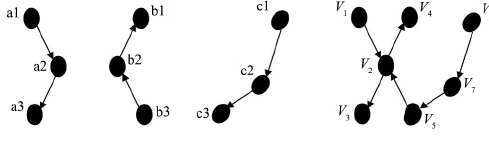
Fig. 7 Graph and 3 edge-disjoint paths. Algorithm 2 PATH